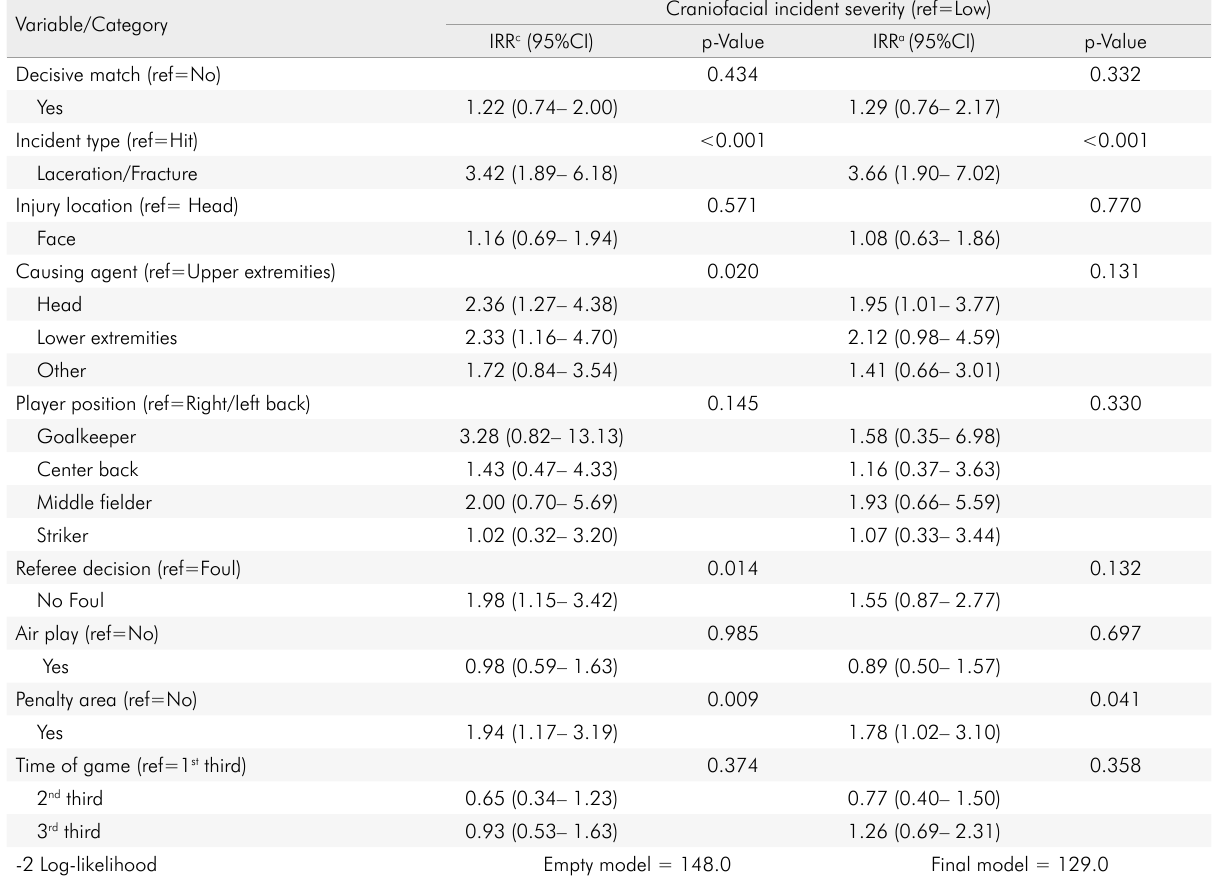
Table 2. Crude (c) and adjusted (a) incidence risk ratio (IRR) of independent variables for craniofacial incident severity in the FIFA World Cups of 2014/2018 and the FIFA Confederations Cup of 2017. Poisson regression models. (n =